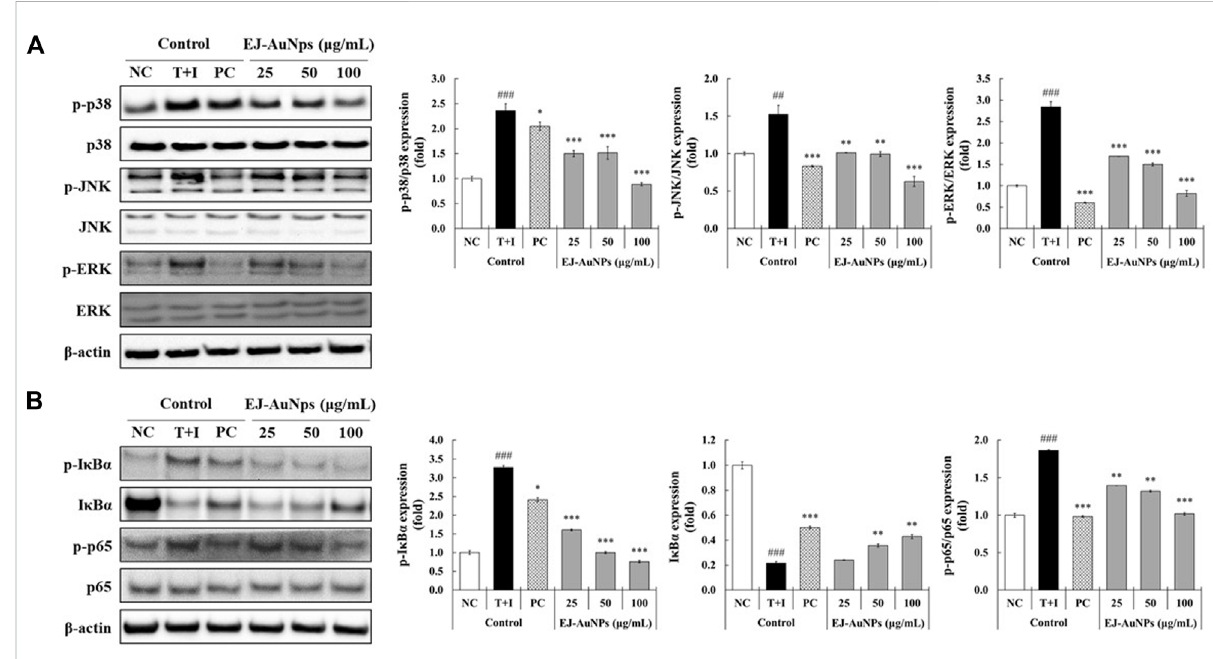
FIGURE 9 Effects of EJ-AuNPs on the (A) mitogen-activated protein kinase (MAPK) and (B) nuclear factor (NF)- κ B signaling pathways in tumor necrosis factor-alpha and interferon-gamma (TNF- α and IFN- γ ; T+I)-treated HaCaT keratinocytes. Results are presented as blotting images of expressed respectiveproteinsandtheirquanti fi cationcalculatedbyfoldratioofphosphorylatedform/totalform,exceptI κ B α .NC,negativecontroltreatedwith medium alone; T+I, in fl ammation-induced control treated with T+I alone; PC, positive control treated with dexamethasone (20 μ g/ml) followed by T+I stimulation. EJ-AuNPs, sample groups treated with EJ-AuNPs followed by T+I stimulation. The crosshatch marks indicate the signi fi cant differences between NC and T+I, and asterisks indicate the signi fi cant differences between T+I and each group. * p < 0.05; ** and ## , p < 0.01; *** and ### , p <